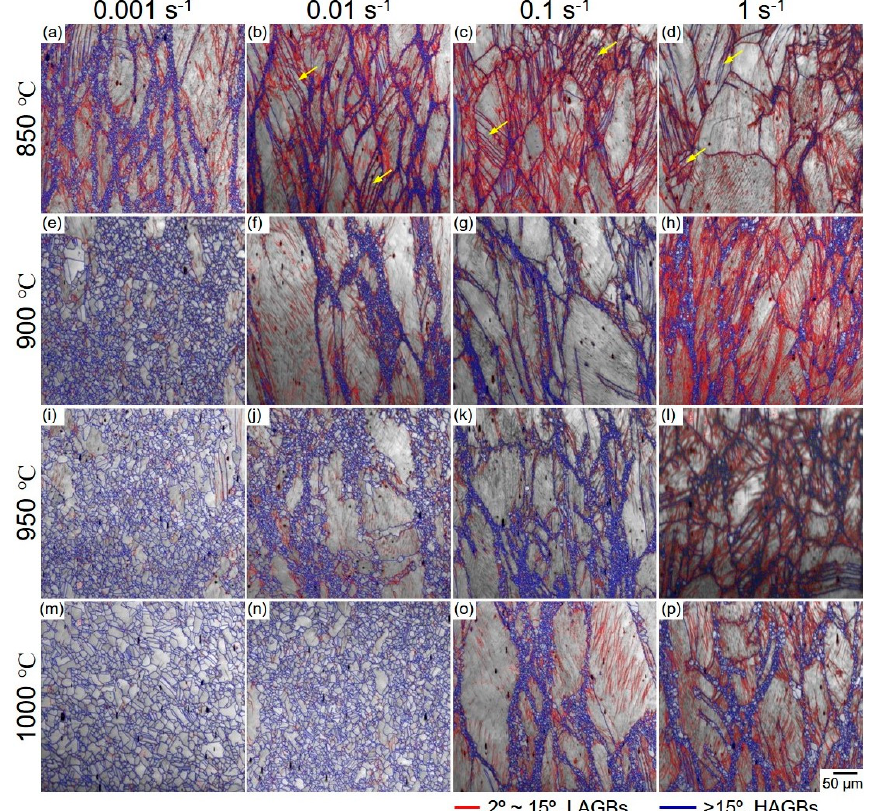
Figure 6. Electron backscatter diffraction (EBSD) image quality (IQ) maps of the CoCrNi alloy hot-compressed at ( a–d ) 850 °C, ( e–h ) 900 °C, ( i–l ) 950 °C, and ( m–p ) 1000 °C with a strain rate of ( a , e , i , m ) 0.001 s − 1 , ( b , f , j , n ) 0.01 s − 1 , ( c , g , k , o ) 0.1 s − 1 , and ( d , h , l , p ) 1 s − 1 , respectively.